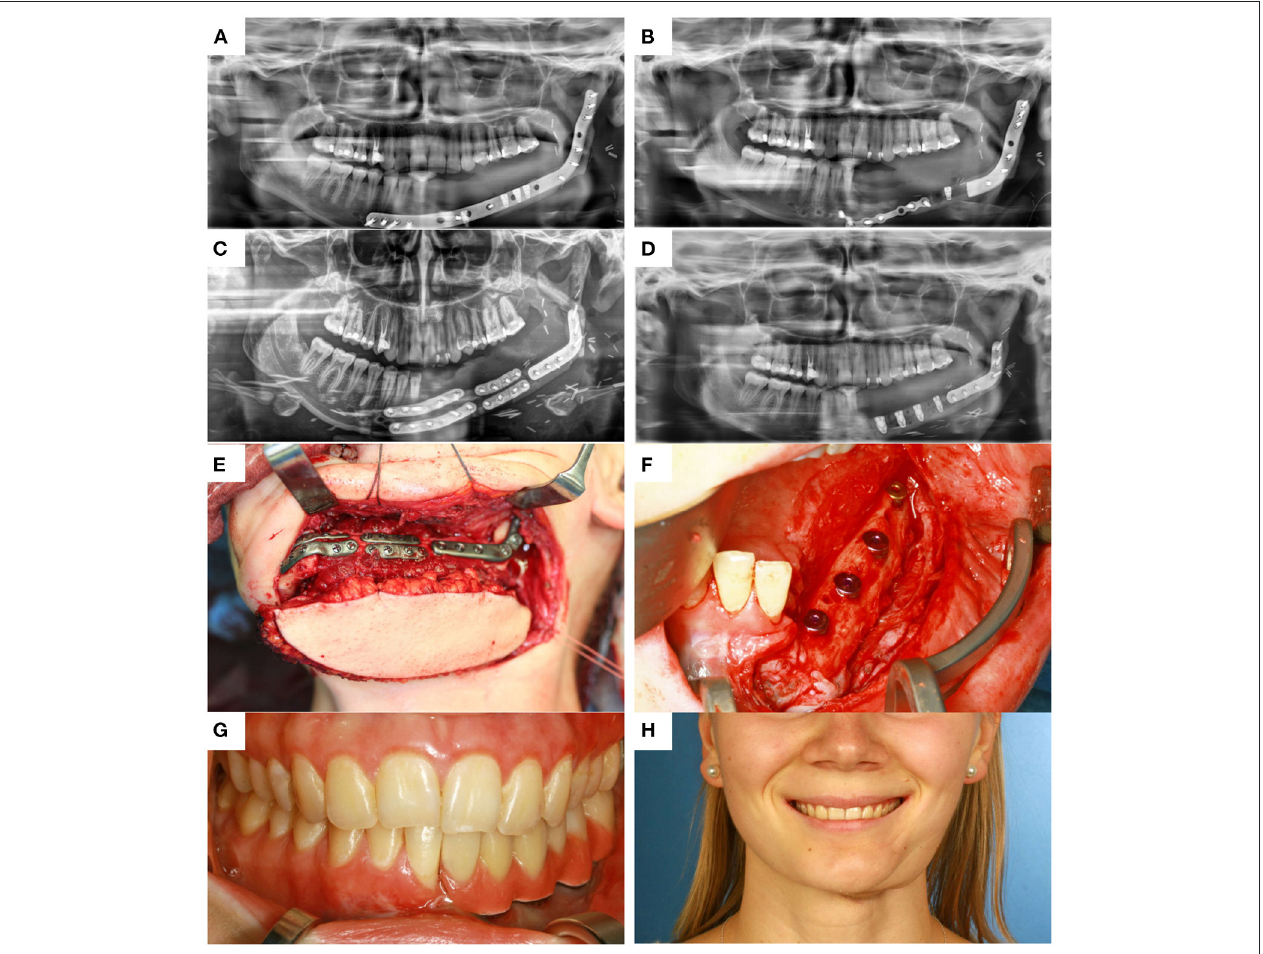
FIGURE 3 | (A) control after placement of dental implants into the first CAD/CAM FFF with reconstruction plate, (B) partial loss of the FFF and partial removal of the reconstruction plate with re-osteosynthesis, (C) control after mandible reconstruction with the second CAD/CAM FFF with miniplates and small reconstruction plate, (D) control after intraoral removal of the miniplates and simultaneous dental implant insertion, (E) intraoperative site of (C) , (F) intraoperative site of (D) , (G) dental rehabilitation with implant supported fixed prosthesis (H) clinical impression 14 months